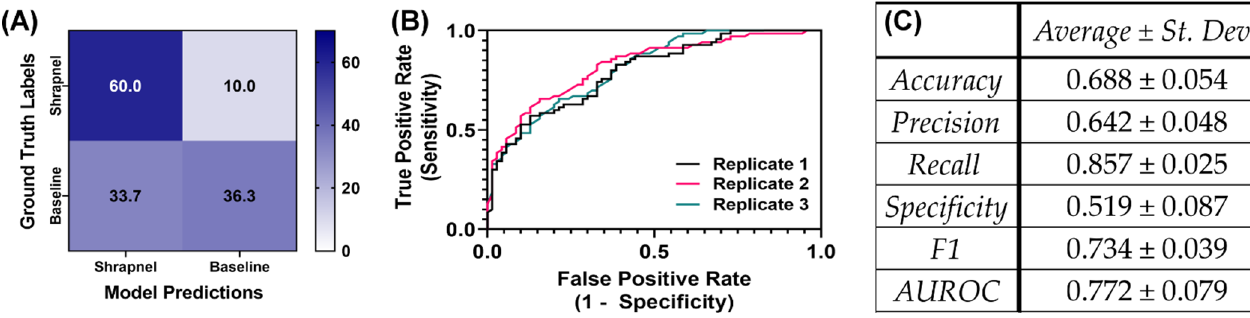
Figure 3. Performance of ShrapML model with blind subject testing. ( A ) Average confusion matrix results across three training replicates for 70 shrapnel and 70 baseline images for a blind test subject. ( B ) Receiver operating characteristic curves and ( C ) summary of performance metrics for three replicate training runs. Results are shown as averages and standard deviations across three replicate trained models.